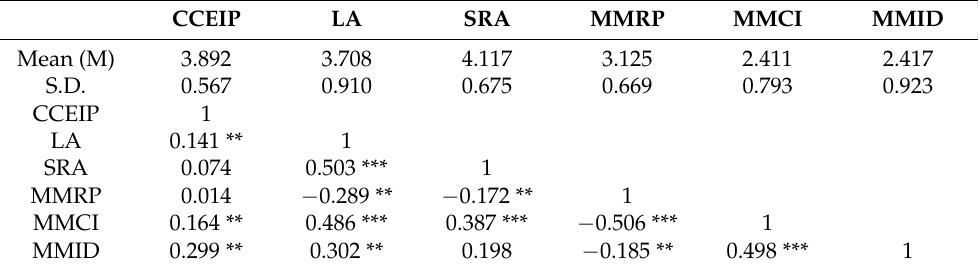
Table 2. Correlation coefficient matrix between